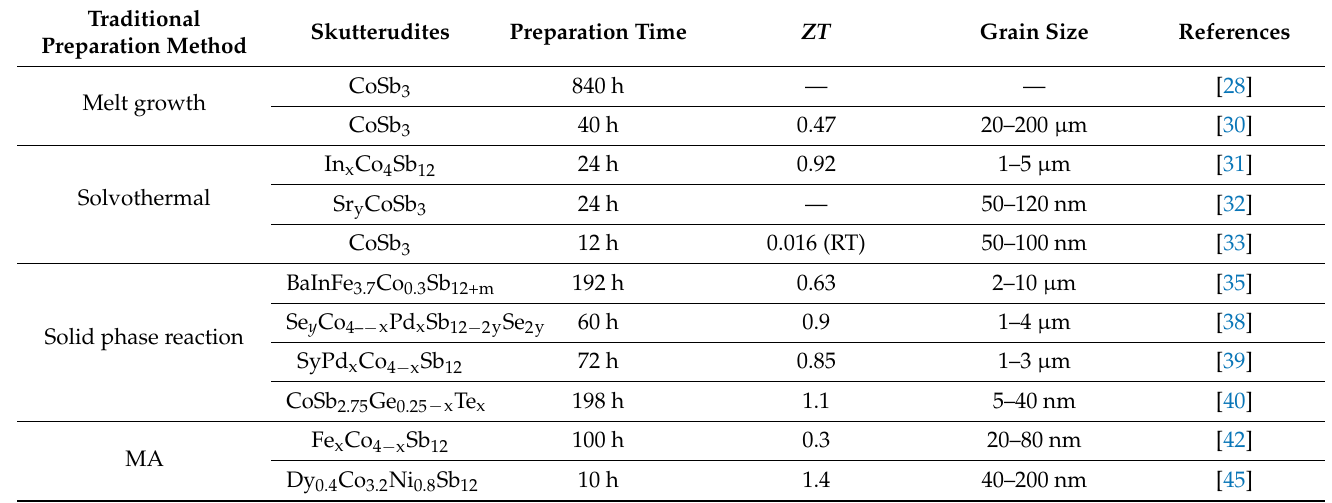
Table 1. Preparation methods, preparation time, grain size and ZT values of several typical skutterudite materials.